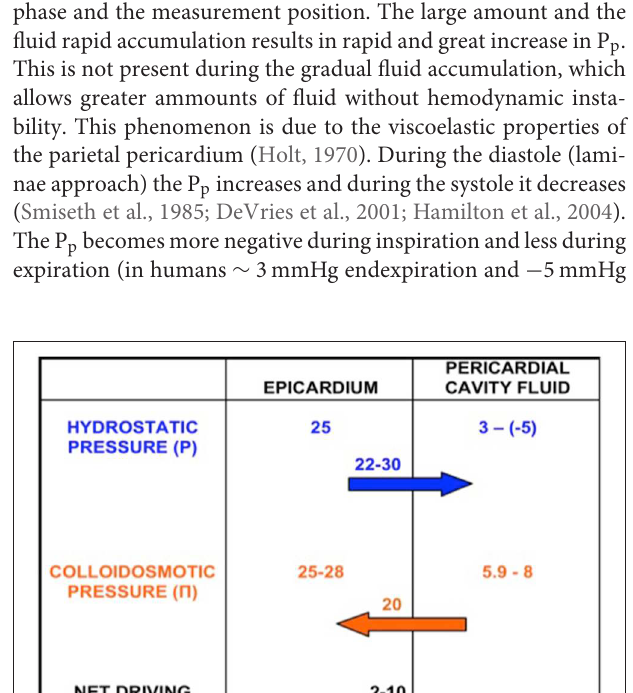
Frontiers in Physiology |